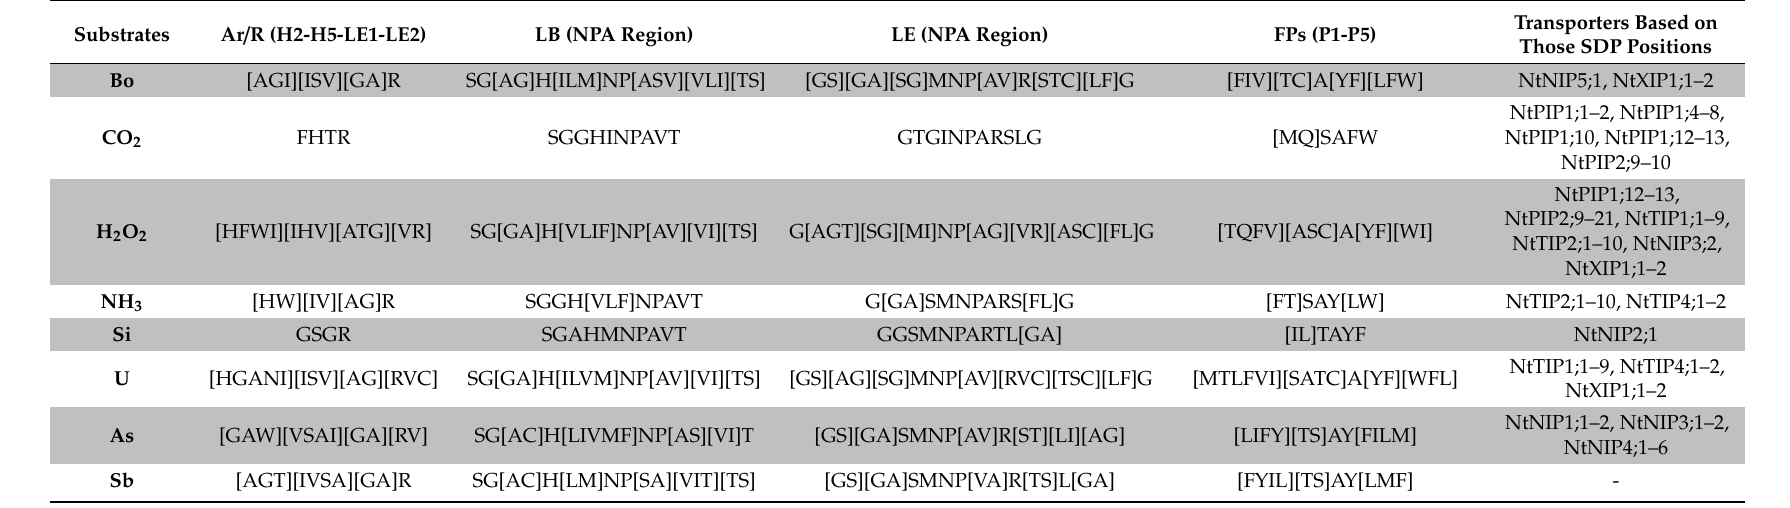
Table 2. Substrate specificity determining positions (SDPs) in